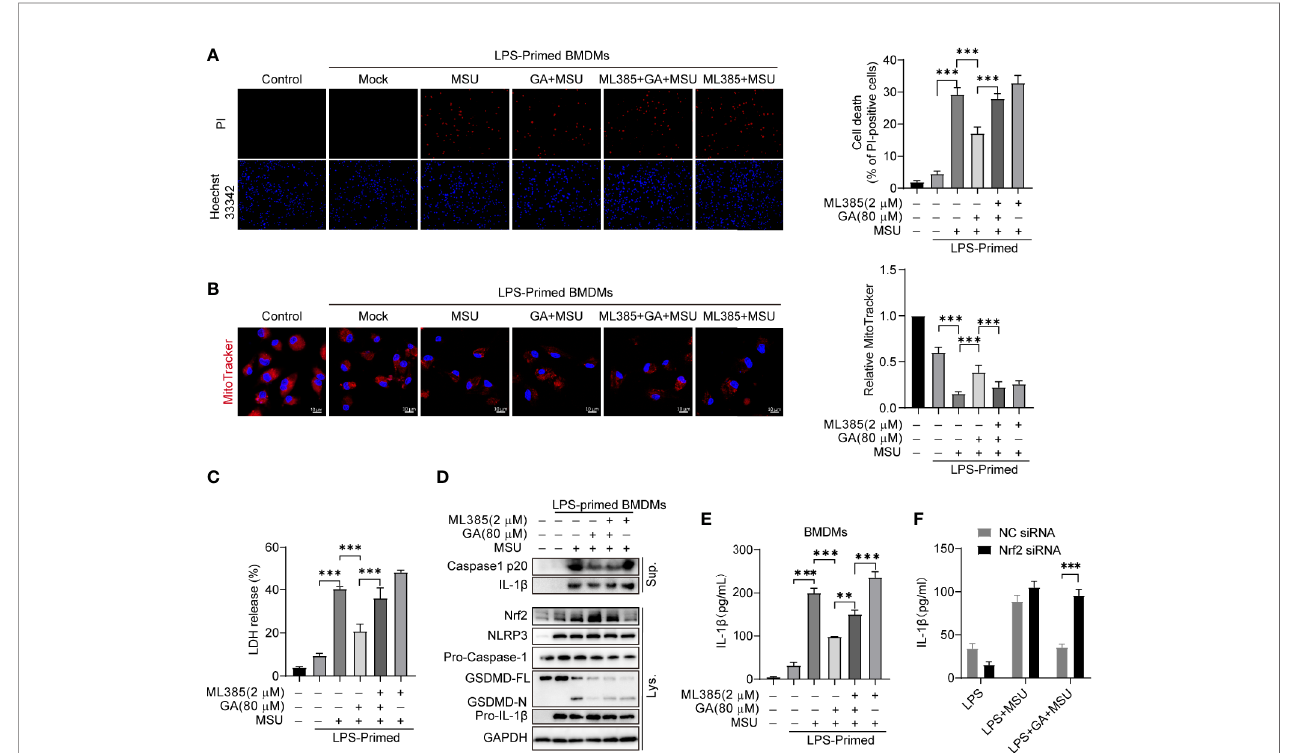
FIGURE 5 | Gallic acid decreases monosodium urate (MSU)-induced NLRP3 in fl ammasome activation partly through Nrf2. (A – E) LPS-primed BMDMs were treated with ML385 for 30 min, incubated with gallic acid for 30 min, and then stimulated with MSU for 6 h. (A) Representative IF images of cell death indicated by PI and Hoechst 33342 staining. The percentage of PI-positive cells relative to all cells was calculated; 10 randomly chosen fi elds were quanti fi ed. (B) Representative IF images of MitoTracker-stained BMDMs. Scale bars, 10 m m. The relative fl uorescence intensity of MitoTracker was compared with that of control BMDMs. (C) The culture supernatant was obtained to analyze LDH release. (D) Supernatants (Sup.) and cell lysates (Lys.) were analyzed by immunoblotting. (E, F) ELISA kit was used to detect IL-1 b levels in culture supernatants. GA, gallic acid. ** P < 0.01, *** P <